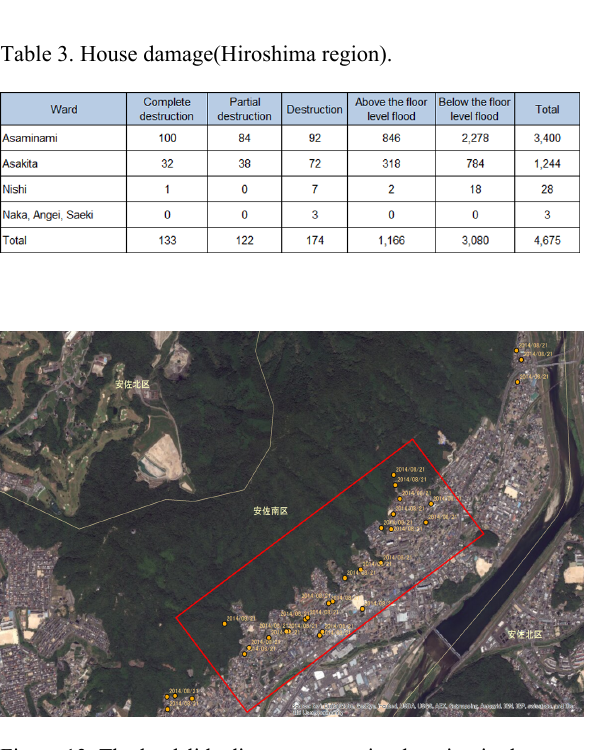
Figure 13. The landslide disaster generation location is